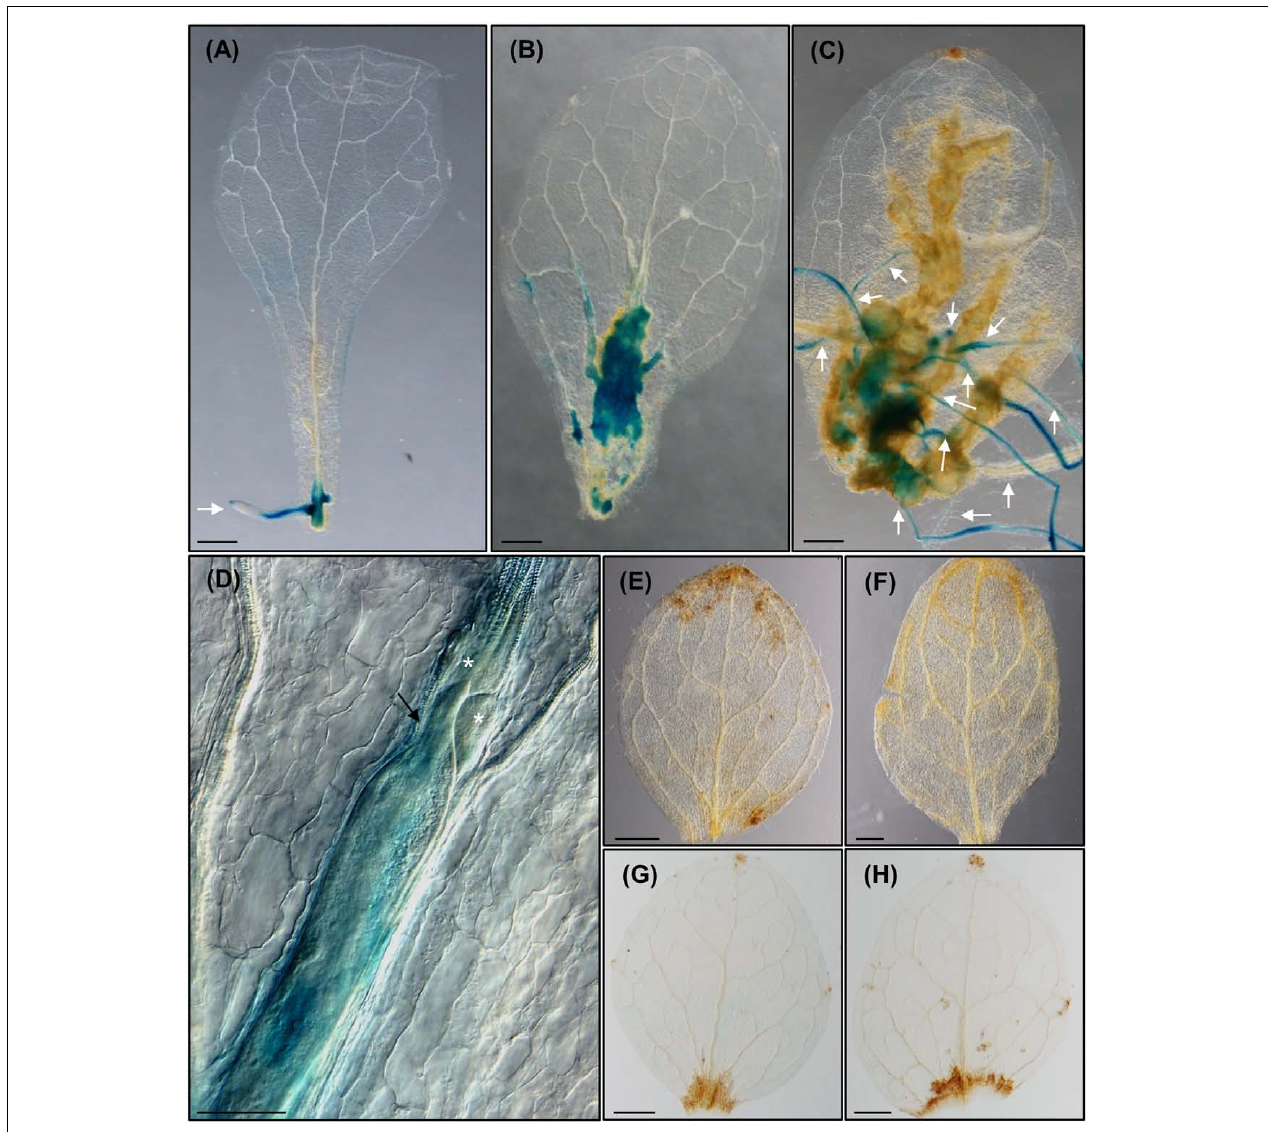
FIGURE 5 | Meloidogyne javanica infection in leaves activates LBD16 , a molecular marker of roots expressed in the xylem pole pericycle in LRP that is also crucial for feeding site formation in leaves. (A) pLBD16::GUS leaf explants cultured in Gamborg B5 medium supplemented with 3% sucrose, in the absence of any additional phytohormones at 8 dac; GUS is observed in primordia and emerged ARs. (B–D) Leaves infected by nematodes at 10 (B) , 24 (C) , and 16 (D) daci, GUS signal is intense in callus-like induced by RKNs and ARs emerging from primary and secondary veins. (E) 35S::LBD16-SRDX leaf explants uninfected or (F) infected by nematodes when cultured in Gamborg B5 implemented with 3% sucrose at 8 dac/daci. (G,H) pLBD16::GUS leaf explants uninfected (G) or infected (H) by nematodes when cultured in Gamborg B5 implemented with 3% sucrose containing 1 µ M of NPA at 8 and 12 dac/daci, respectively. Nematodes cannot establish in 35S::LBD16-SRDX plants nor in NPA treated leaves. White arrows, white arrow heads, black arrows and asterisks indicate the ARs, the galls, the nematode and the GCs, respectively. N ≥ 45. Scale Bars: 500 µ m (A–C,E–H) and 200 µ m (D)